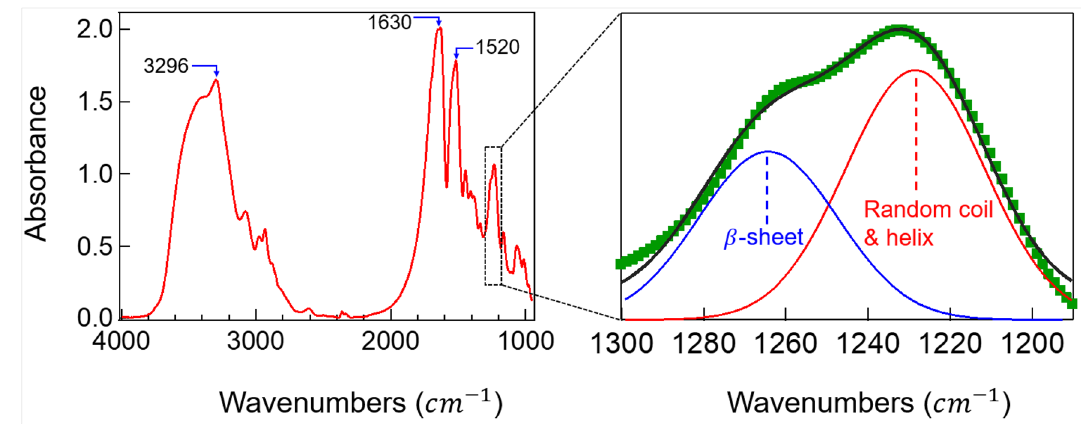
Figure 4. FTIR spectra of fibroin fibers produced by turbulent drawing.